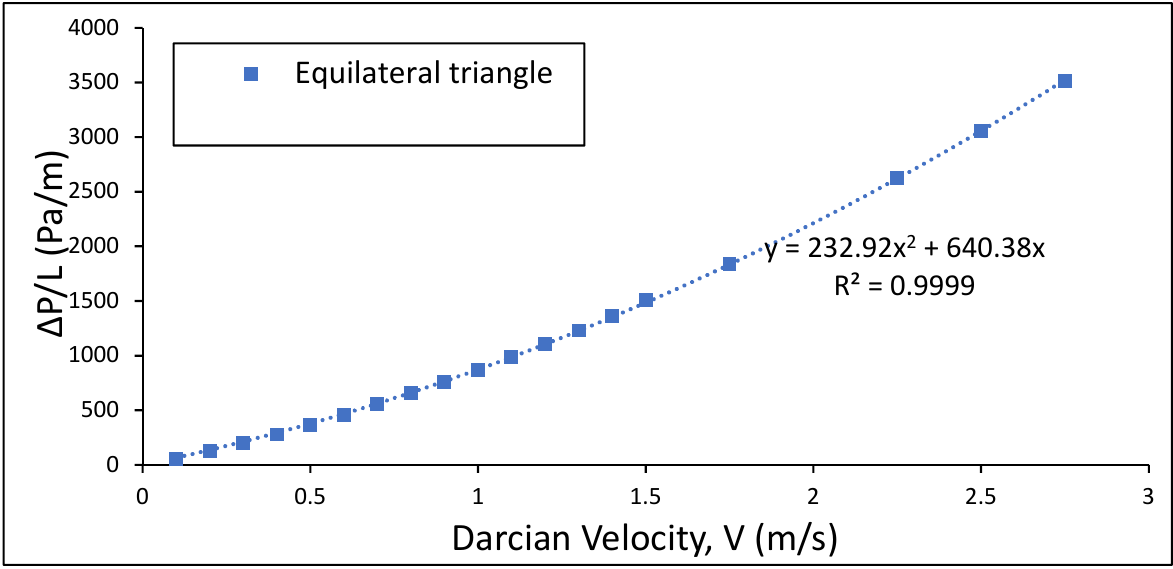
Figure 7. Pressure drop per unit length in flow direction as predicted by the EPS model with an equilateral ‐ triangle ar ‐ rangement.